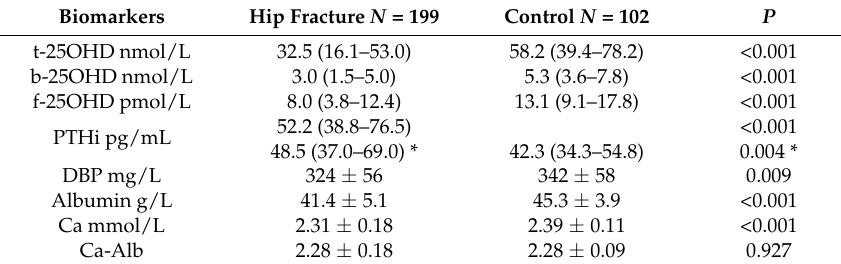
Table 2. Comparisons of laboratory markers in the groups with and without